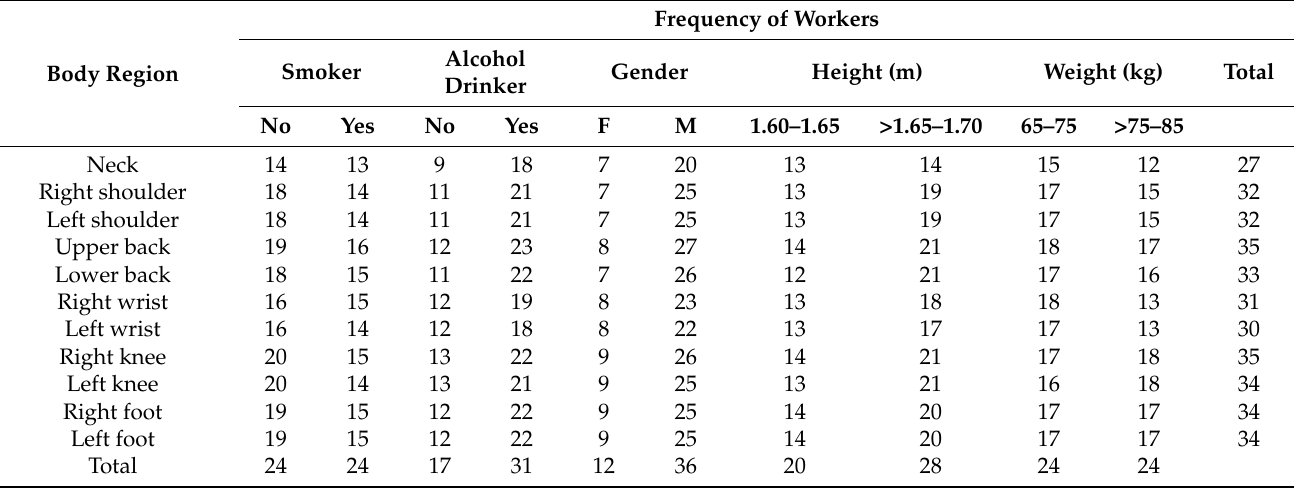
Table 6. Frequency (f) of workers by personal characteristics who perceived musculoskeletal symp- toms by body region for more than 30 days and all days during the last 12